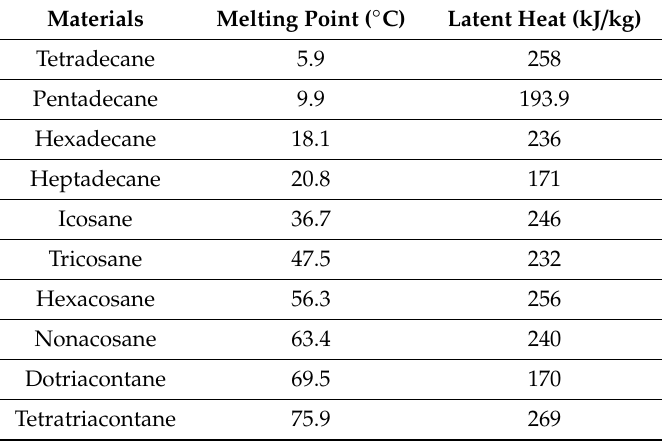
Table 1. Thermal physical properties of some para ffi n